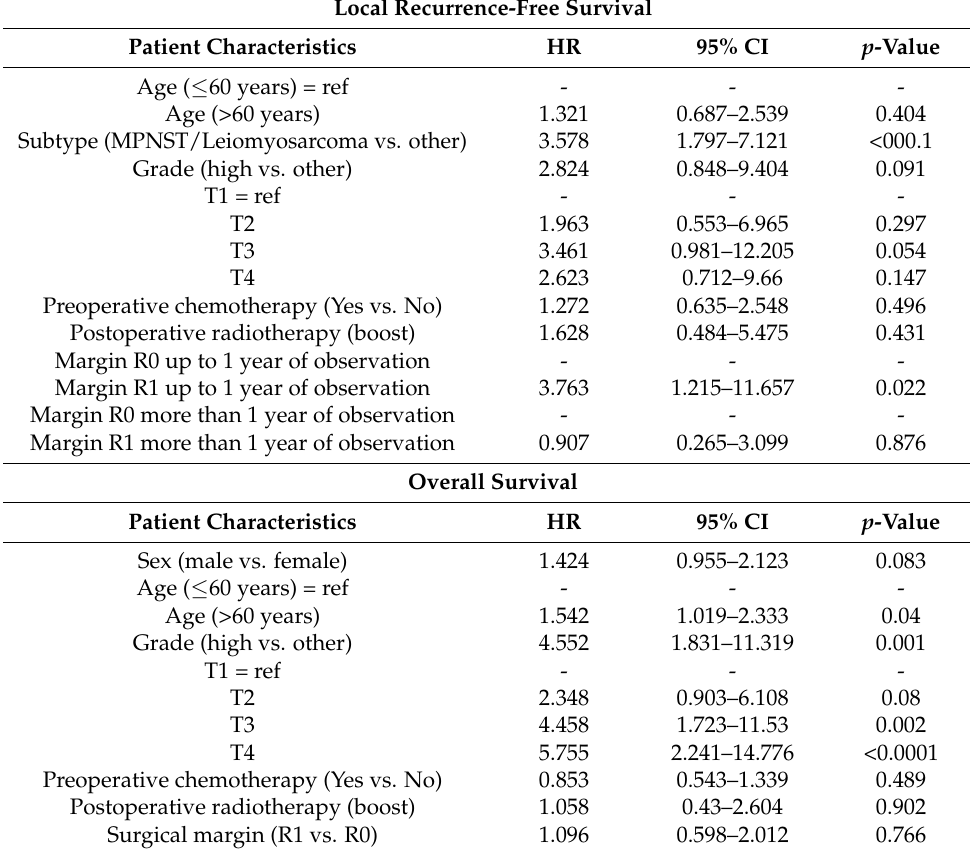
Table 4. Multivariate analysis of variable factors for LRFS and OS (CI—confidence